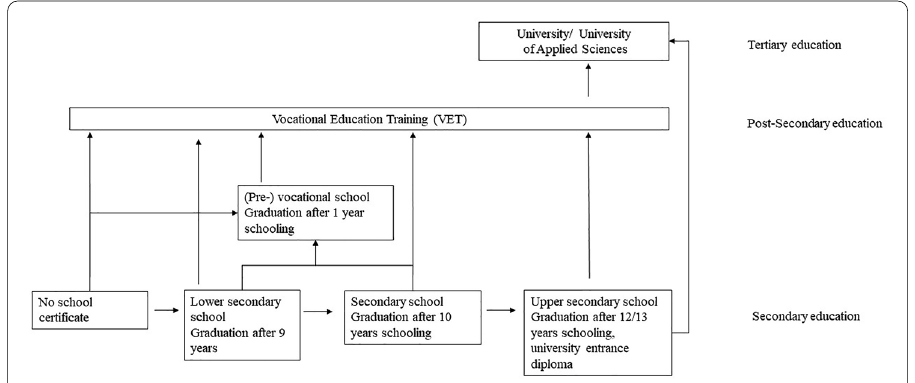
Fig. 1 The educational system in